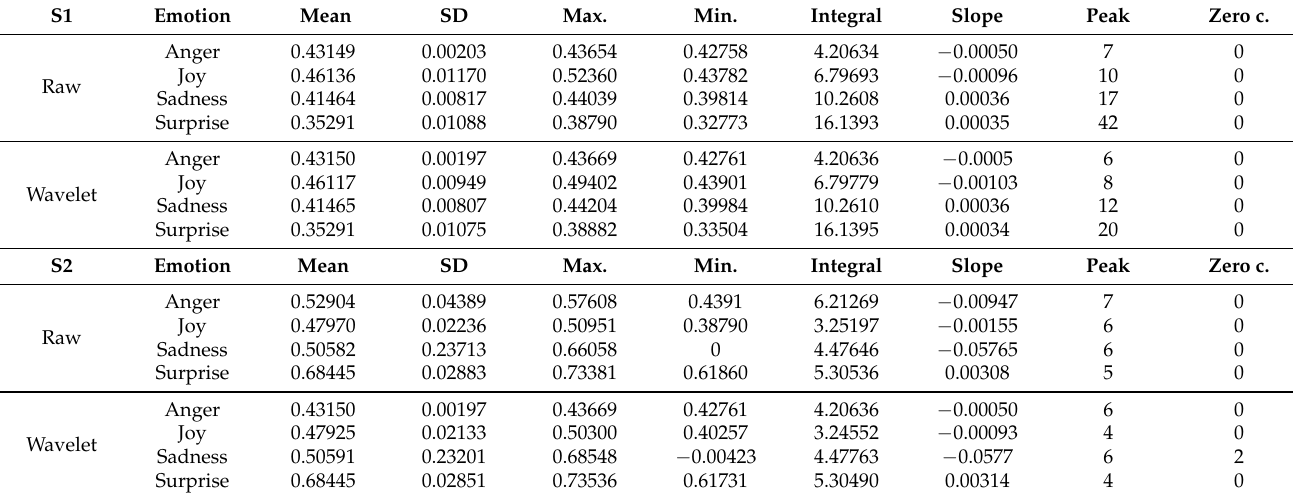
Table 1. Features in EDA data of all subjects